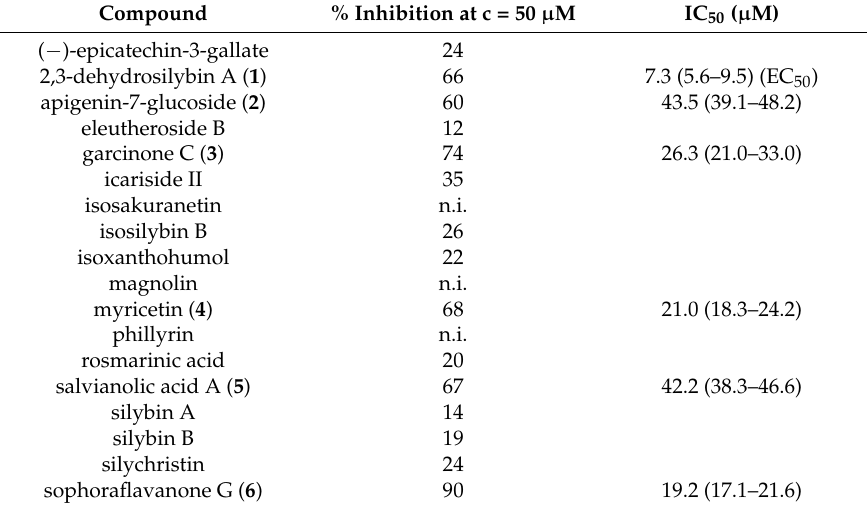
Table 1. Inhibitory activity of the in silico hits on Lm PTR1. Data represents inhibition values in % at 50 µ M (n.i. = no inhibition at 50 µ M), and IC 50 values of compounds with >50% inhibition at this concentration in µ M (in brackets: 95% confidence interval; n = 4 to